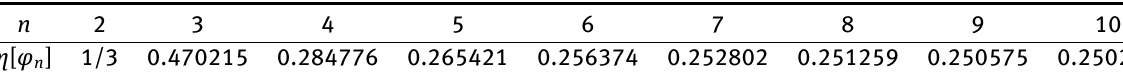
Table 2: The maximal error parameter ME n . n 2